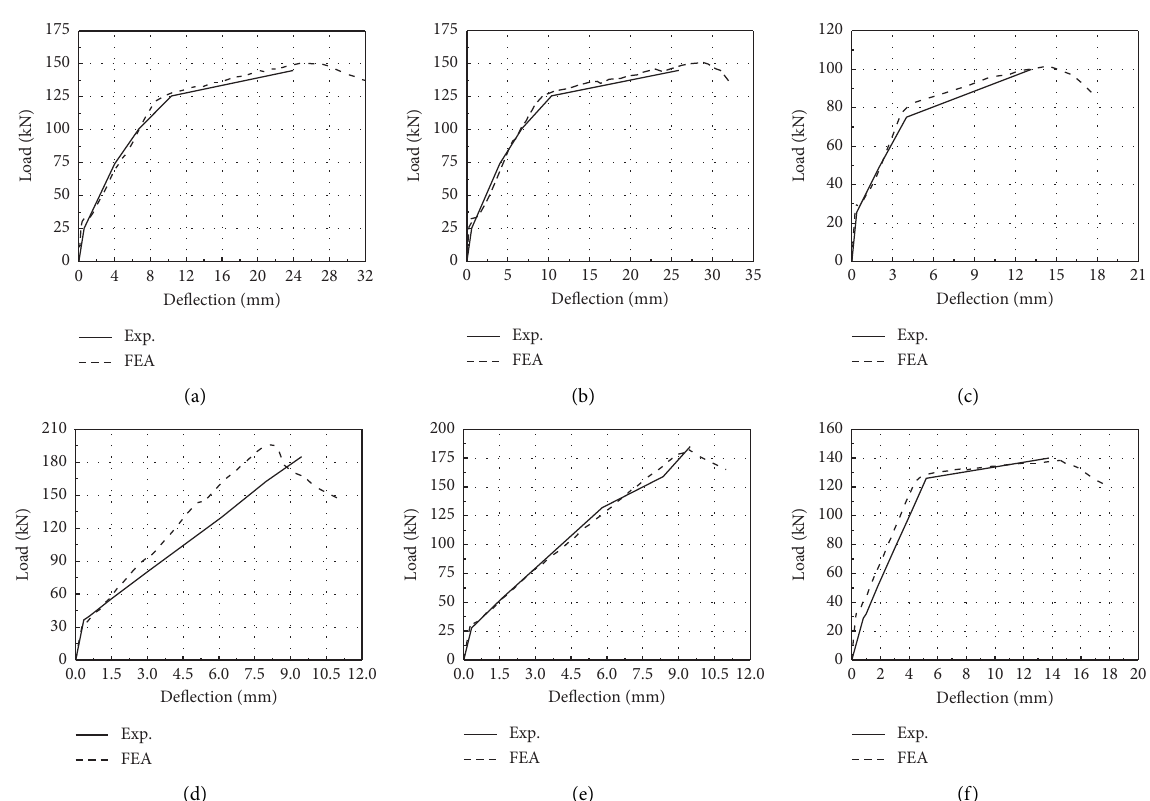
Figure 16: Comparison between experimental and analytical load-deflection curves: (a) BKW1; (b) BKW2; (c) PKW1; (d) BKJ1; (e) BKJ2; (f) PKJ1.